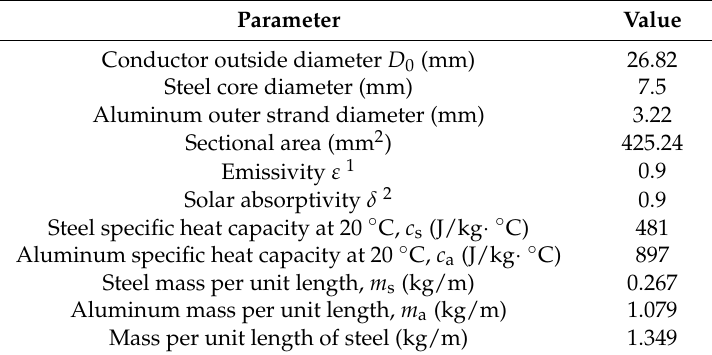
Table A2. Main parameters of ACSR LGJ400/35